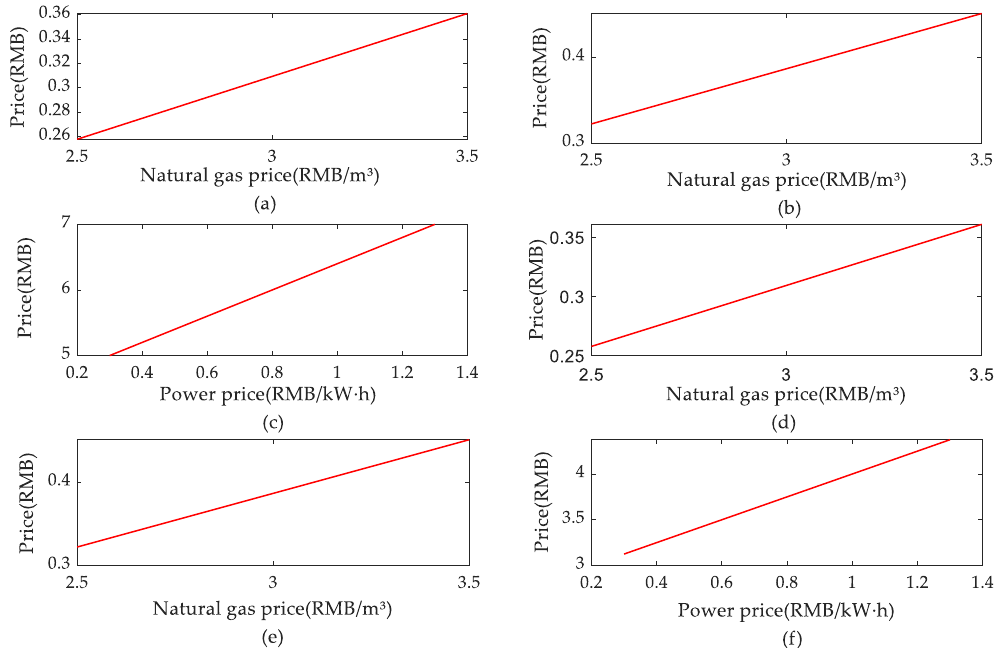
Figure 3. Heating and cooling energy cost per 1 kW · h. ( a ) Cost of direct-fired lithium bromide absorption cold / warm water units (DLB) absorbing flue gas to produce cooling energy; ( b ) Cost of DLB consuming natural gas to produce cooling energy; ( c ) Cost of electric refrigerator (ER) consuming power to produce cooling energy; ( d ) Cost of DLB absorbing flue gas to produce heating energy; ( e ) Cost of DLB consuming natural gas to produce heating energy; ( f ) Cost of electric boiler (EB) consuming power to produce heating energy.